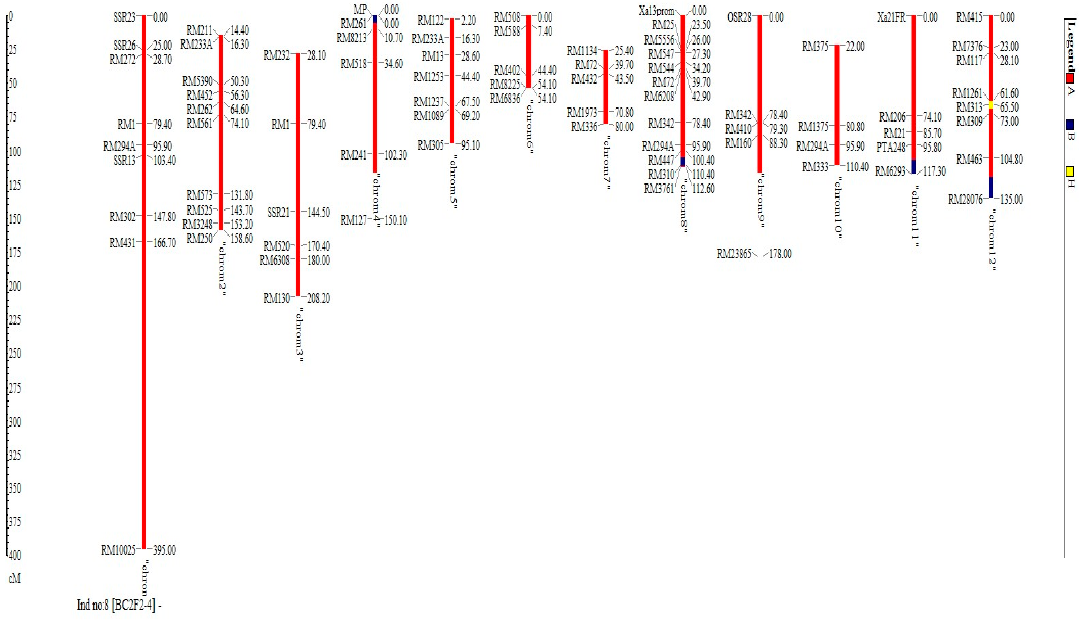
Figure 5. Highest chromosome-wise recurrent parent genome recovery of the improved selected lines observed in BC 2 F 2 -4.